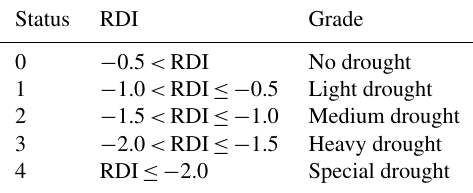
Table 2. Grading classification of meteorology drought based on